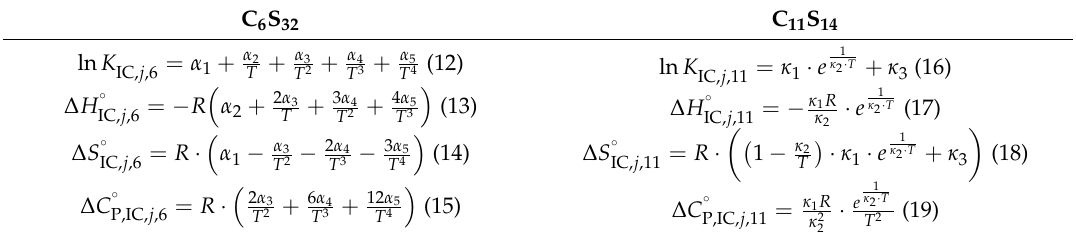
Table 3. Thermodynamic functions derived from fit functions of both C n S m